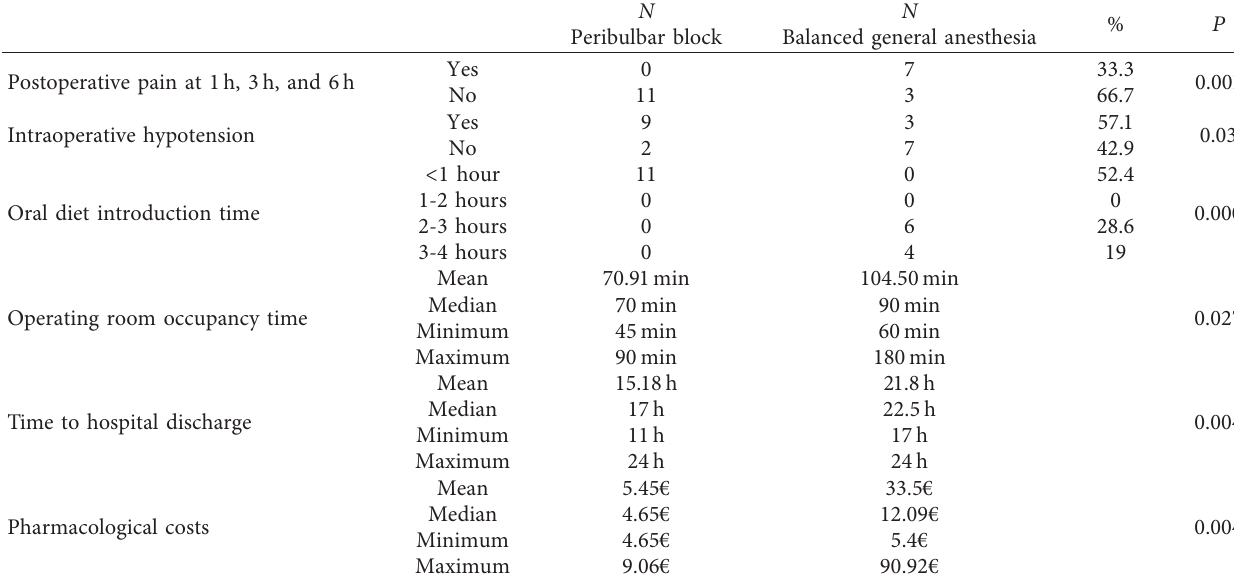
Table 1: Results according to the type of anesthesia.